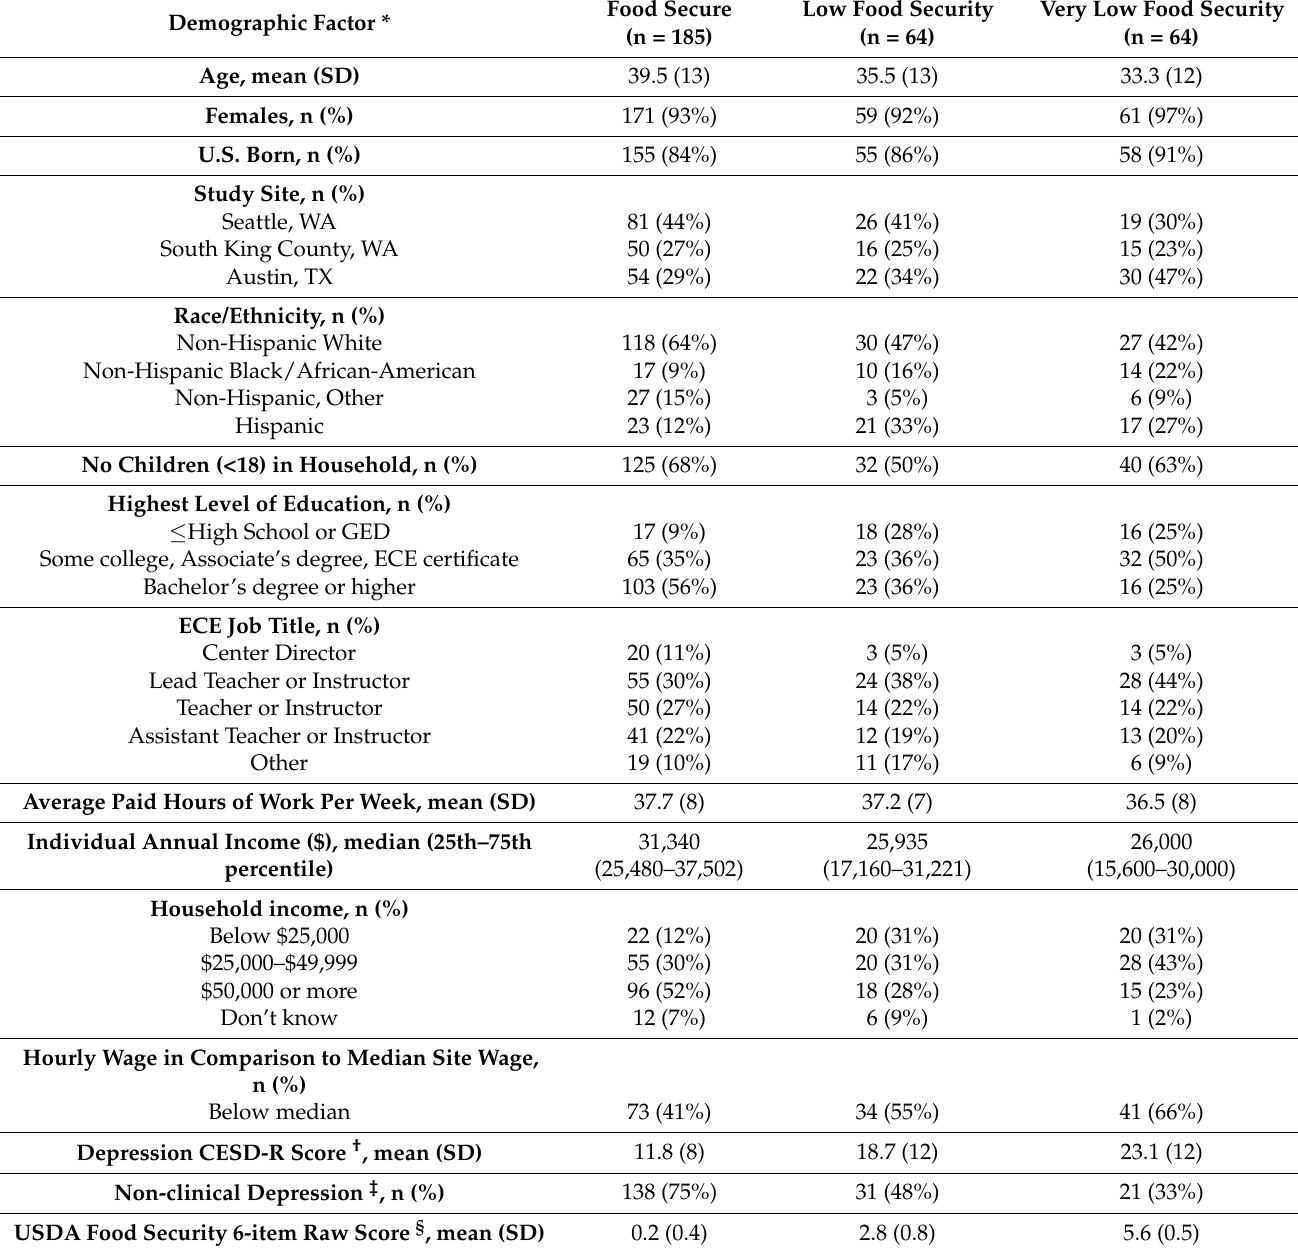
Table 1. Characteristics of the study cohort of 313 early care and education (ECE) providers, by food security status,